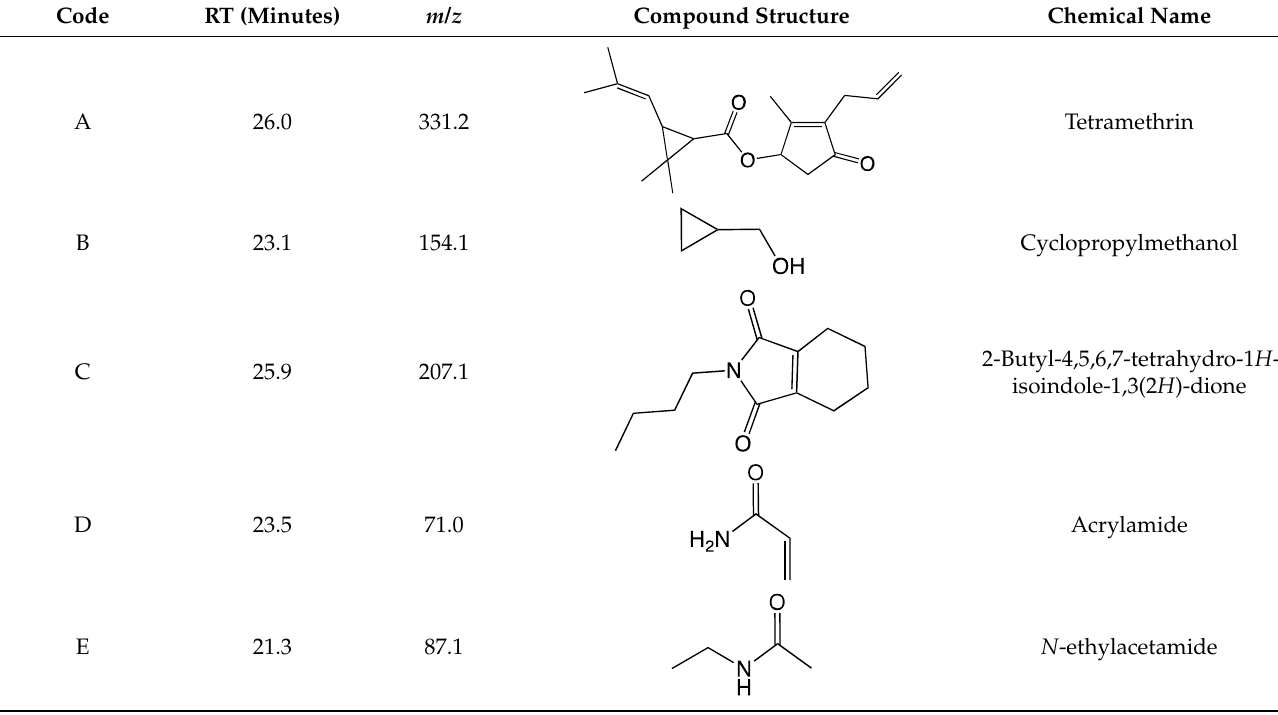
Table 4. Tetramethrin and its intermediate metabolites during degradation with strain A16 in GC-MS analysis. Code